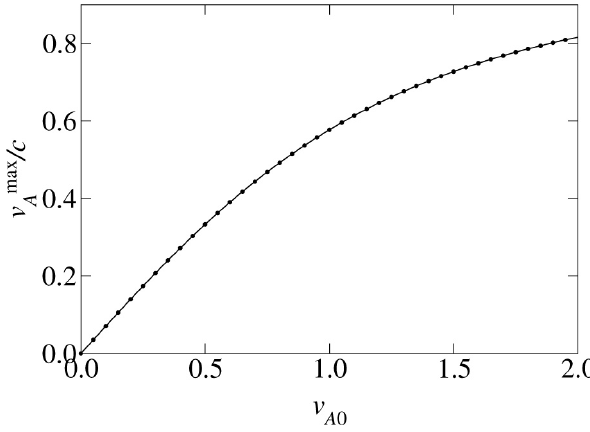
Fig. 10. Maximum Alfvén speed as a function of v A 0 , obtained from solving the kinetic dispersion relation Eq. (40) for very low temper- ature (solid line), and from the fluid model, Eq. (23)